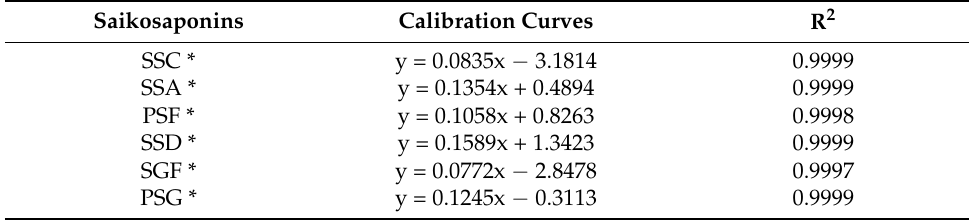
Table 1. Calibration curves of saikosaponin standard analysis.